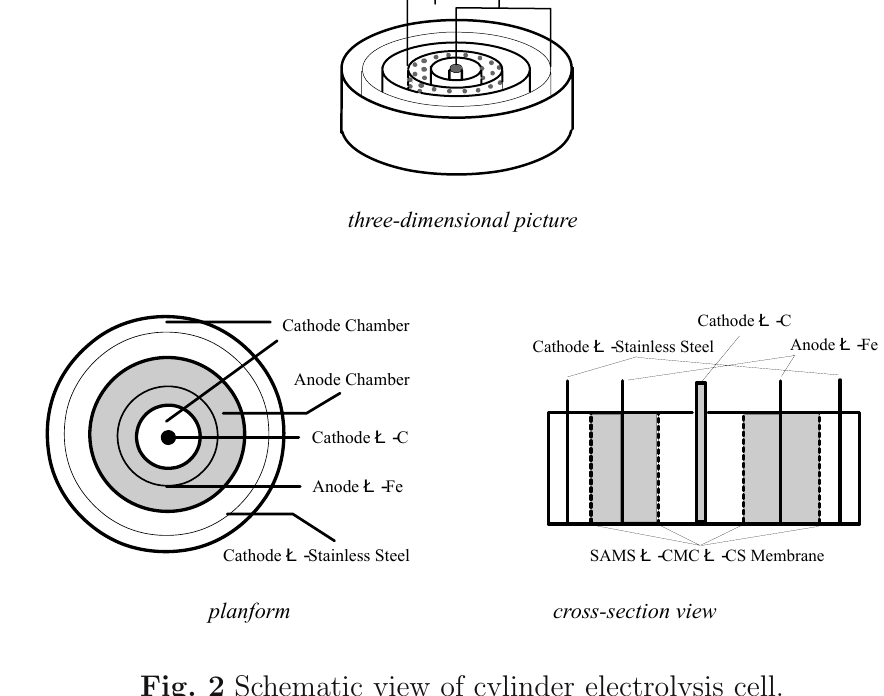
Fig. 2 Schematic view of cylinder electrolysis